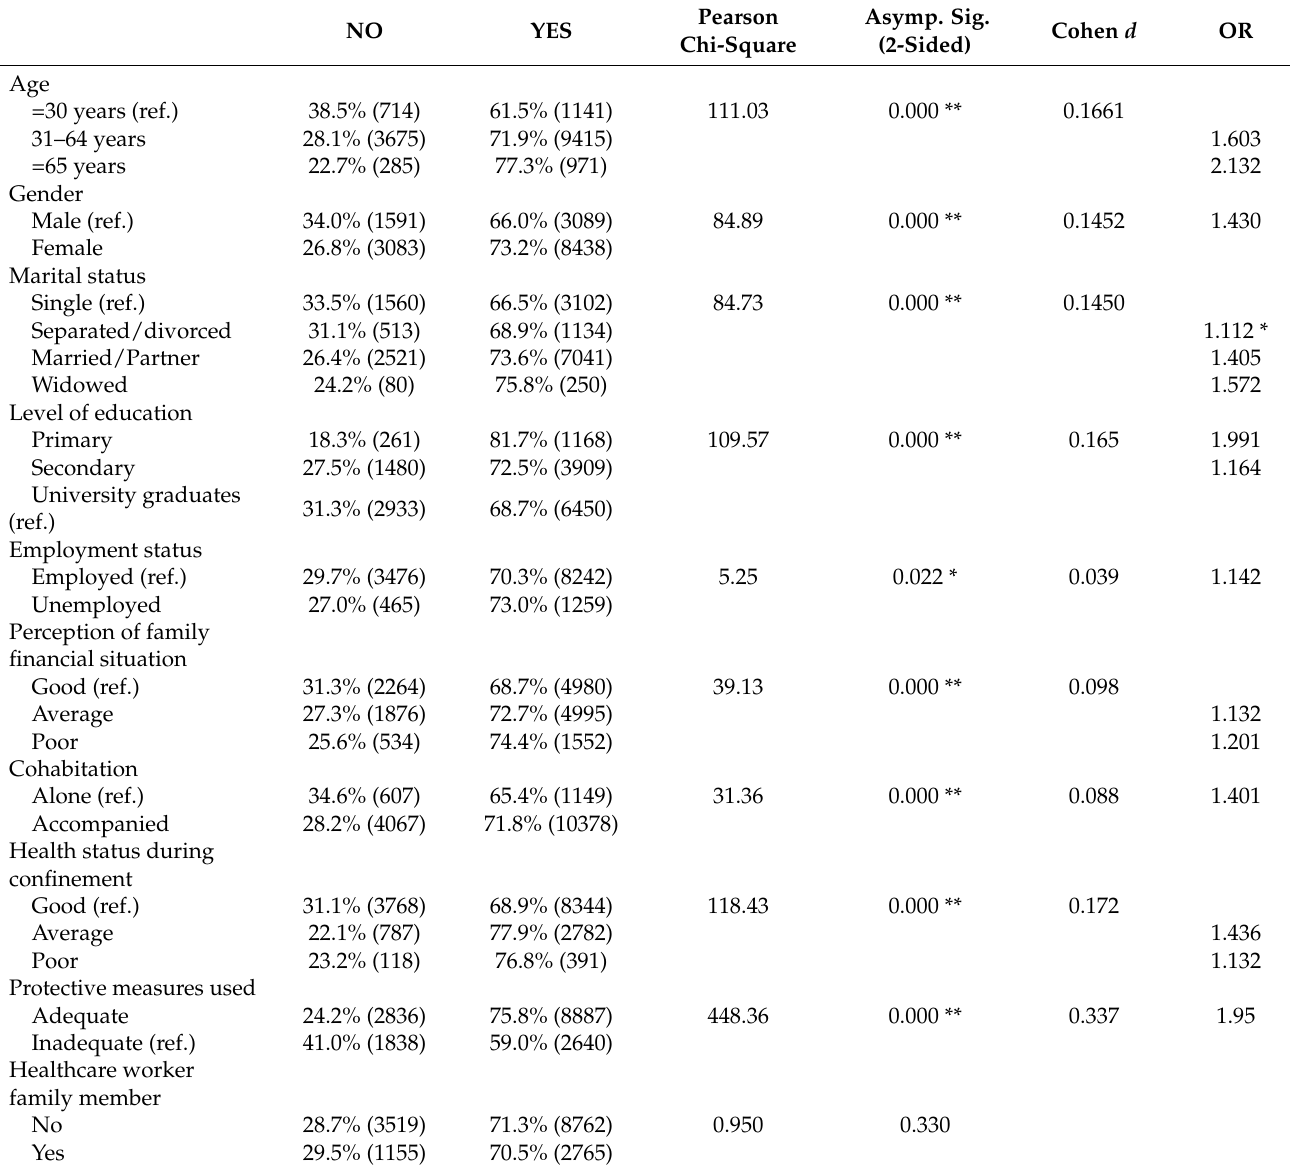
Table 2. Fear of infection according to sociodemographic